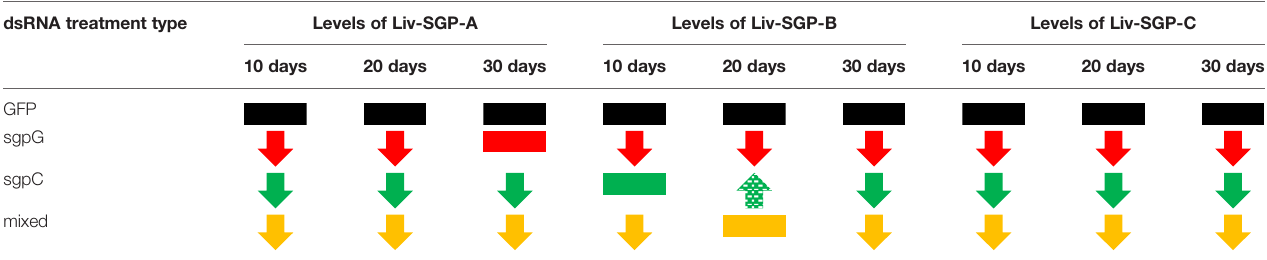
Colorforeachtreatmentgroupcorrespondswiththatutilizedin Figure5 .Levelsofgeneexpressionforeachgroupareshownwiththefollowingsymbols.GFP-dsRNAgroup(basallevels): black rectangles; decreased expression: downward-facing solid arrows; increased expression: upward-facing shaded arrow(red, green oryellow rectangle: no change frombasal